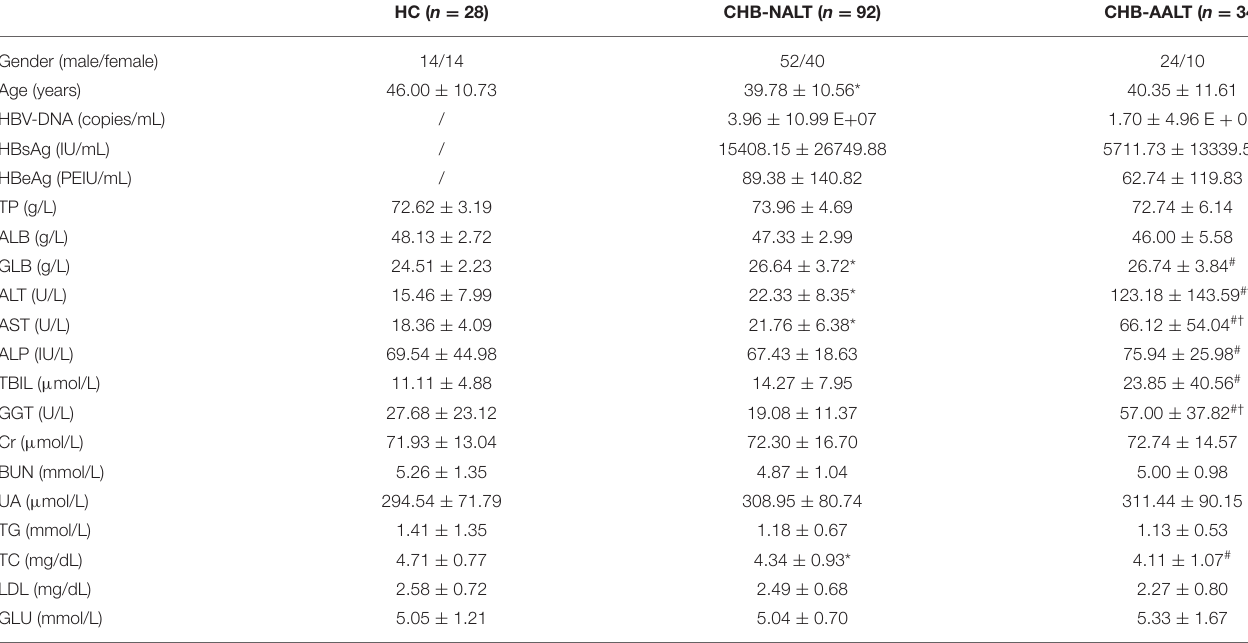
TABLE 1 | Baseline characteristics of study subjects for serum